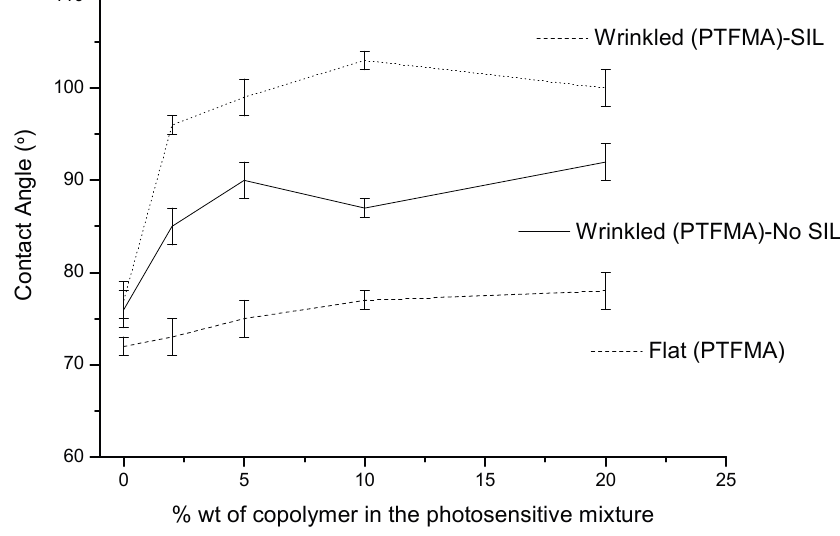
Figure 5. Variation of the contact angle as a function of the wt% of P(TFMA- co -MMA) copolymer incorporated within the photosensitive mixture prepared using either silanized glass covers (SIL) or cleaned glass covers (No